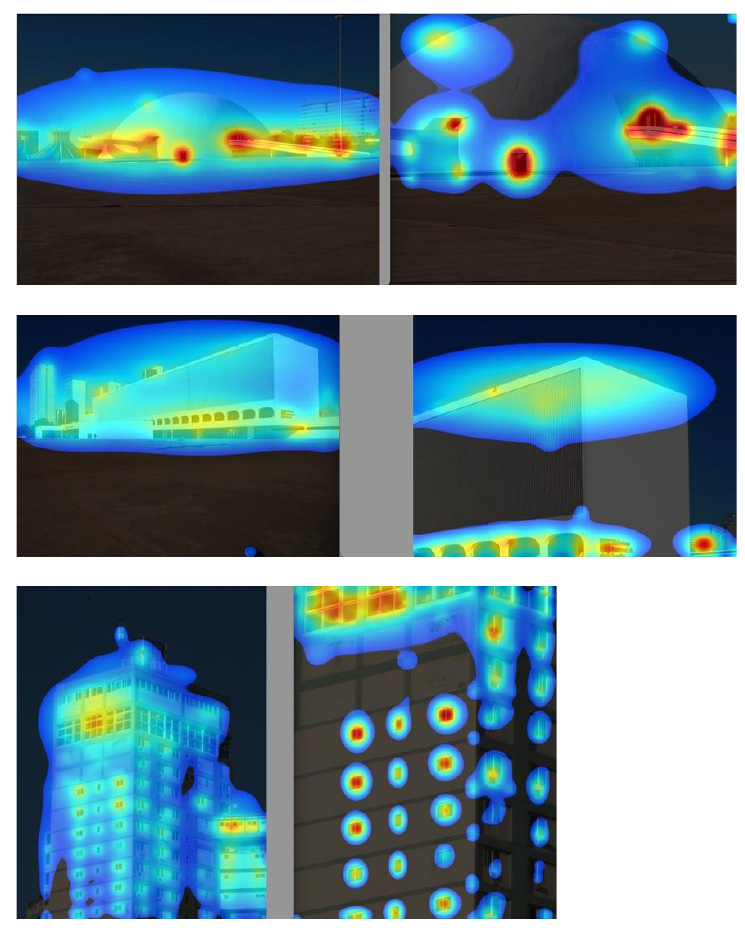
Figure 5. VAS heatmaps of original images next to zo omed-in images, processed separately. For example, the heat maps of image 1 (top of Figure 5) suffer from salient hot spots that draw the eye away from taking in the building in its entirety. This anomaly only increases by zooming in, because the hot spots become intensified. The two dominant hot spots are in fact decorative sculptural elements that totally overwhelm the building’s de- sign and tectonics (see top of Figure 3). The heat map of image 2 (middle of Figure 5), which seems fairly homogeneous from afar, breaks up upon approach as shown in the heat map of the zoomed-in image 2near. The main body of the building no longer engages the user, implying that it ceases to be of unconscious interest as one moves towards it. The façade might as well not be there. A different, but equally undesirable, effect occurs with image 3 (bottom of Figure 5), which breaks up into separated hotspots on a grid as we zoom in, shown in image 3near. Unconscious engagement is maintained, but it’s the wrong type of interest as far as its con- sequences on human health. Monotonous repetition of hotspots was mentioned earlier as it possibly correlates with headaches. Image 3 therefore also poses problems for the user. Our most dramatic result using the relative attention scans comes from scanning zoomed-in images 1 an d 12 together (Figure 6, below, zoomed in to a comparable “dis- tance”— not by a constant factor, as was the case in Figure 4). See how the visual attention jumps dramatically from the details of image 1 compared to details of image 12 (an order- ing of opposites that was determined by informal estimations of the Beauty Scale).